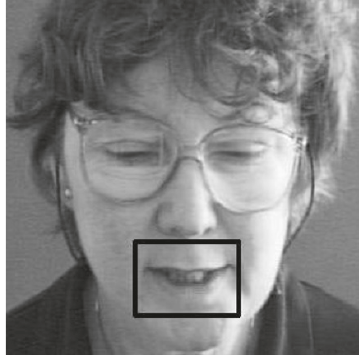
Figure 1: Lip tracking on the BANCA